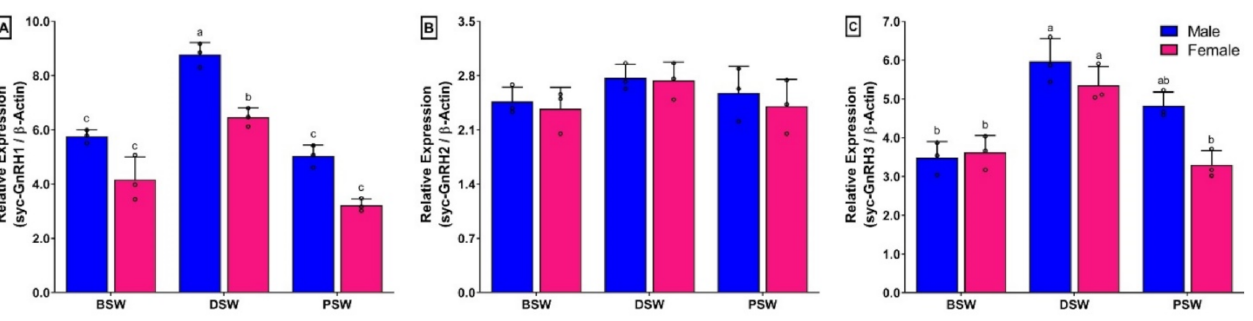
Figure 9. Relative mRNA expression levels (2 − ∆∆ CT ) of three GnRH isoforms in the brain during induced spawning events in captive reared male and female small yellow croaker: ( A ) syc-GnRH1, ( B ) syc-GnRH2, and ( C ) syc-GnRH3. For all bar graphs, raw data points (black circle) represent biological replicates, error bars represent standard deviation, and different letters above the bars indicate significant differences ( p < 0.05) among spawning events. BSW, before spawning; DSW, during spawning; PSW, post